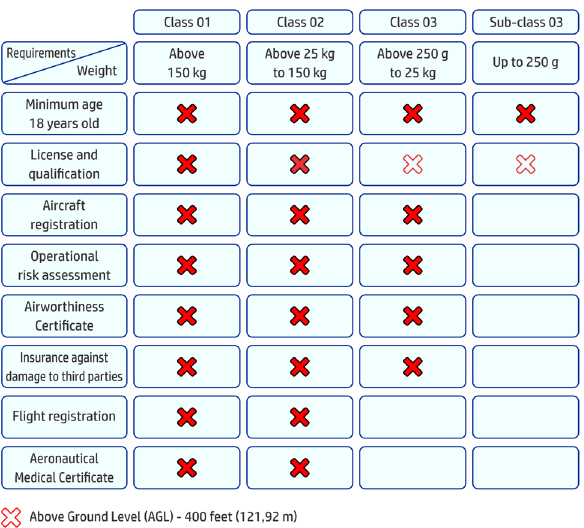
Table 1. Classes and requirements of ANAC accounted for the MicroBrosh UAV